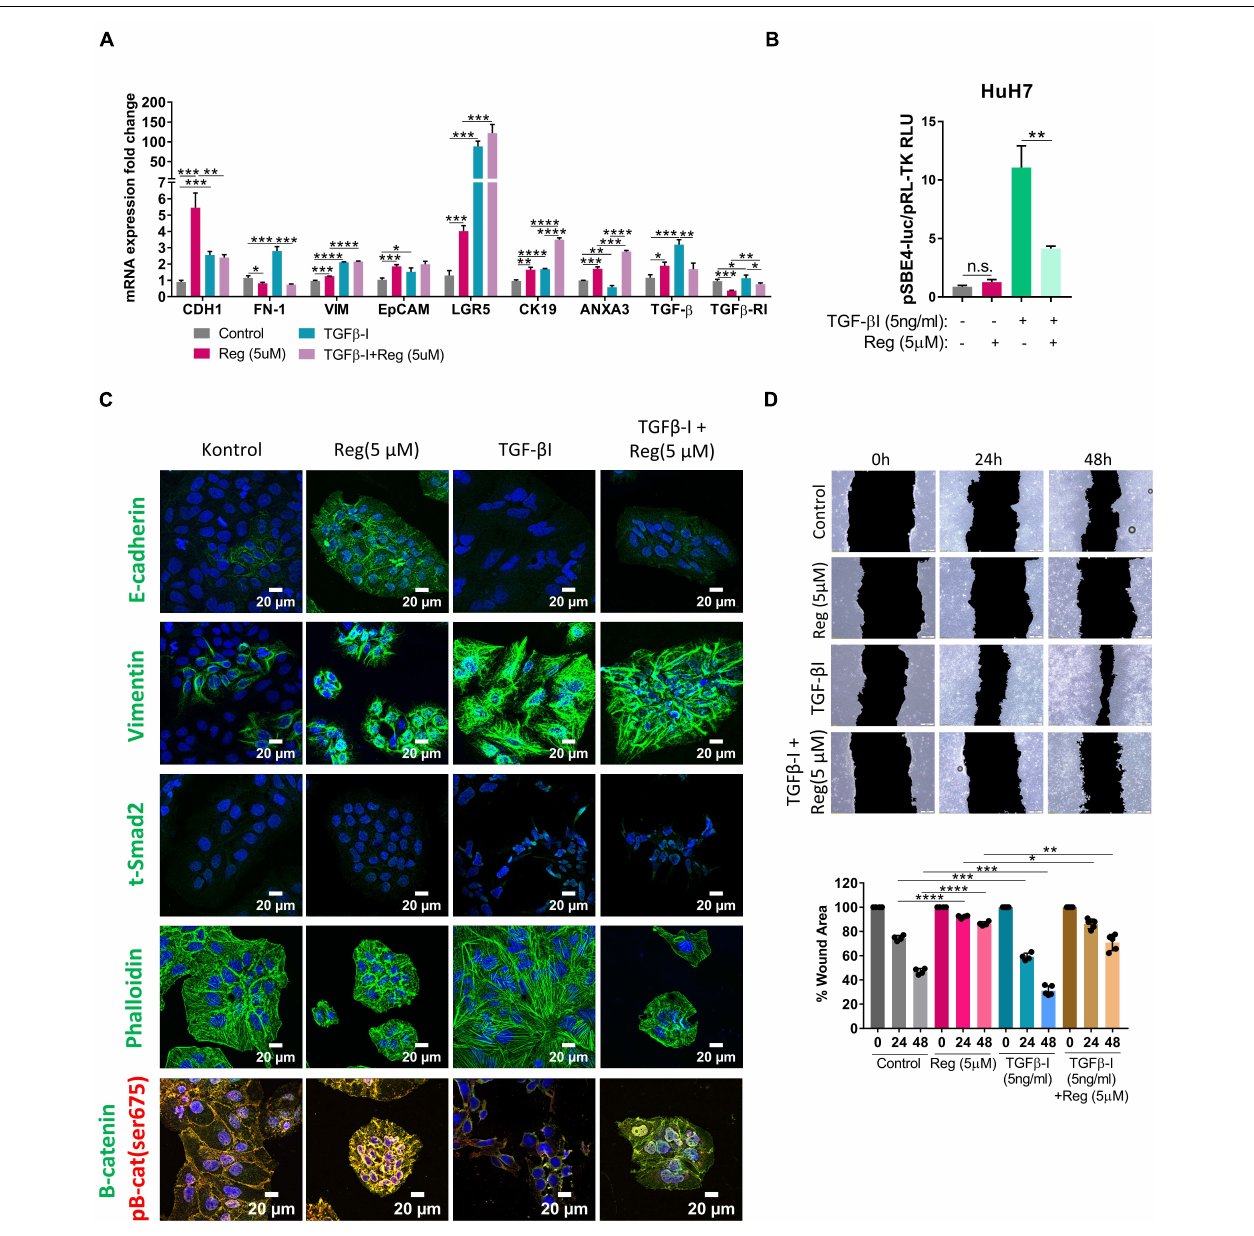
FIGURE 4 | TGF- β treatment partially reverses regorafenib induced effects. (A) Expression of mesenchymal and epithelial genes were analyzed by q-PCR. Data represent the average of at least three independent experiments. (B) TGF- β reporter activity in basal and regorafenib treated cells was measured using pSBE4-Luc/pRL-TK construct. (C) Expressions of E-CAD, VIM, SMAD2 and β -catenin were analyzed in control and treated (TGF- β 1, regorafenib, or combined) cells by immunofluorescence. Images were acquired on a Carl Zeiss LSM 880 AxioObserver confocal microscope with a C-Apochromat 40x/1.2 W, Korr FCS M27 objective. (D) Scratch assay was performed in control and treated (TGF- β 1, regorafenib, or combined) cells. Wound area was calculated using ImageJ MRI wound healing tool. p > 0.05 (n.s.), p ≤ 0.05 (*), p ≤ 0.01 (**), p ≤ 0.001 (***), p ≤ 0.0001 (****). Error bars indicate standard deviation